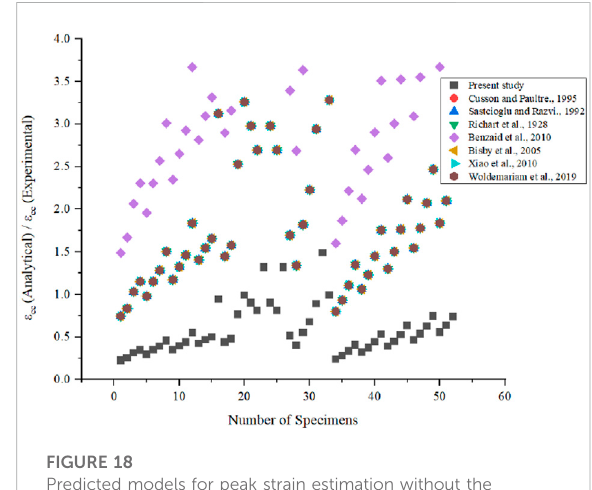
FIGURE 17 Predicted models for peak strain estimation without the longitudinal reinforcement.